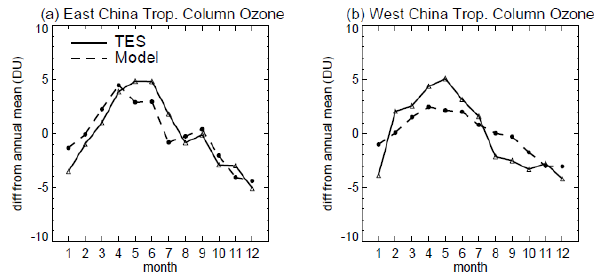
Fig. 4. Month-to-month variations of tropospheric ozone column (TOC) averaged over east (a) and west (b) China retrieved from TES (solid line) and simulated by the model (dash line). Displayed are TES version 3 level-2 TOC retrievals averaged over three years (2006–2008) to improve data representativeness. Model results are for 2006. The monthly variability is shown by subtracting annual mean TOC from the monthly